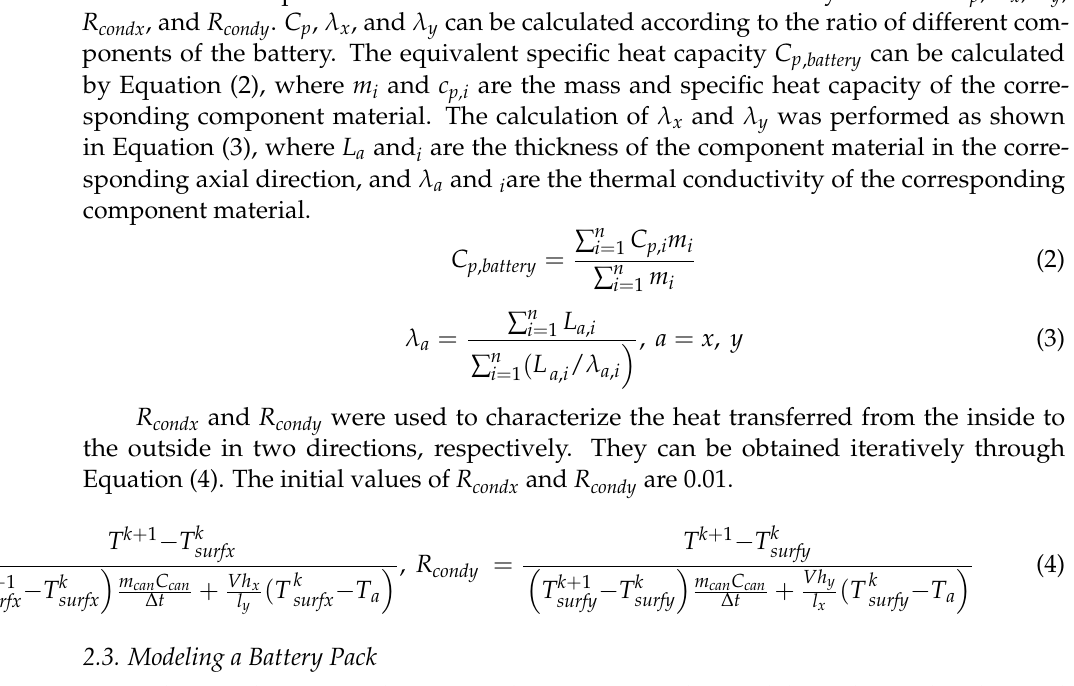
Figure 2. The current used for identification [29].